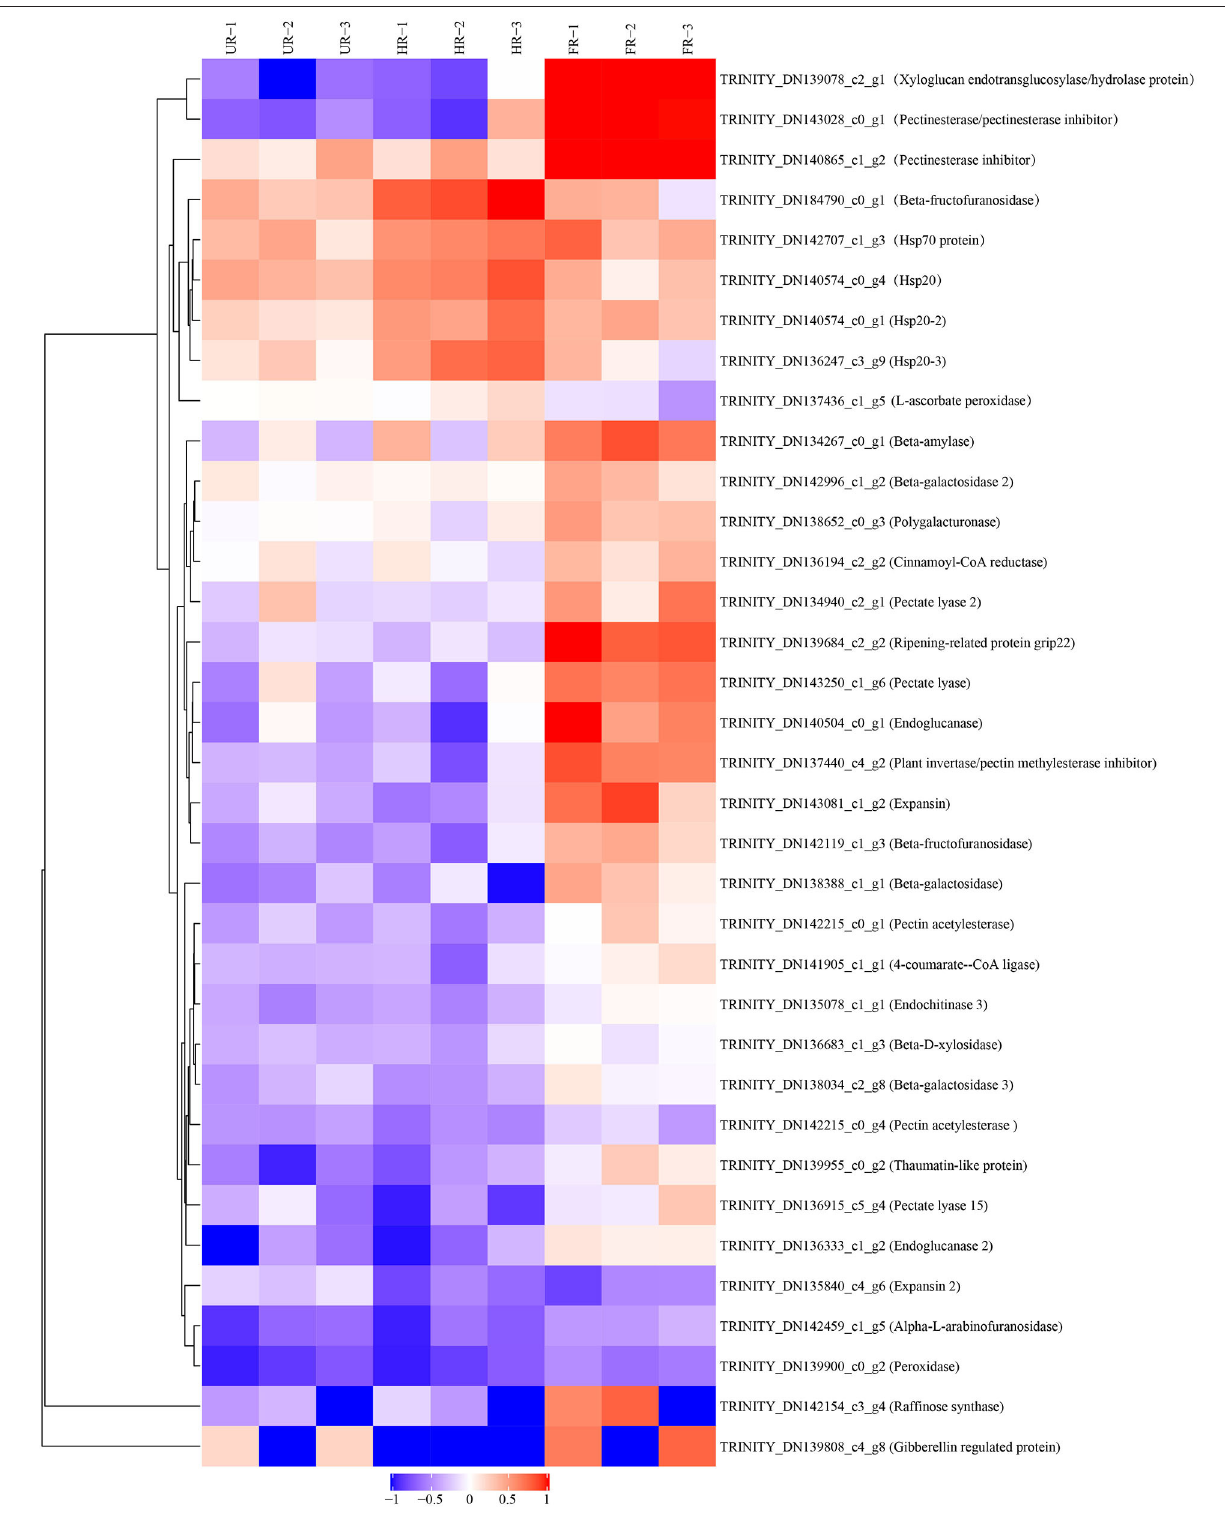
Frontiers in Nutrition |